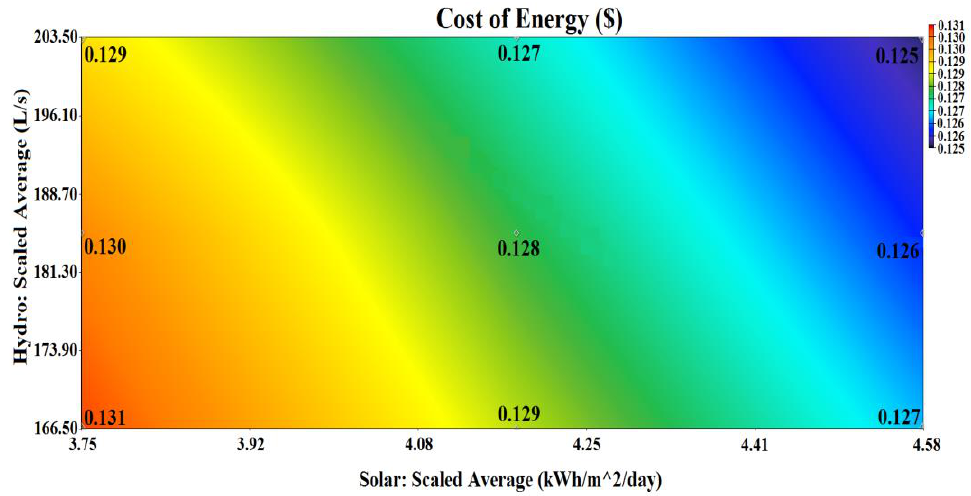
Figure 32. Surface-type plot showing scaled stream flow against scaled irradiance.